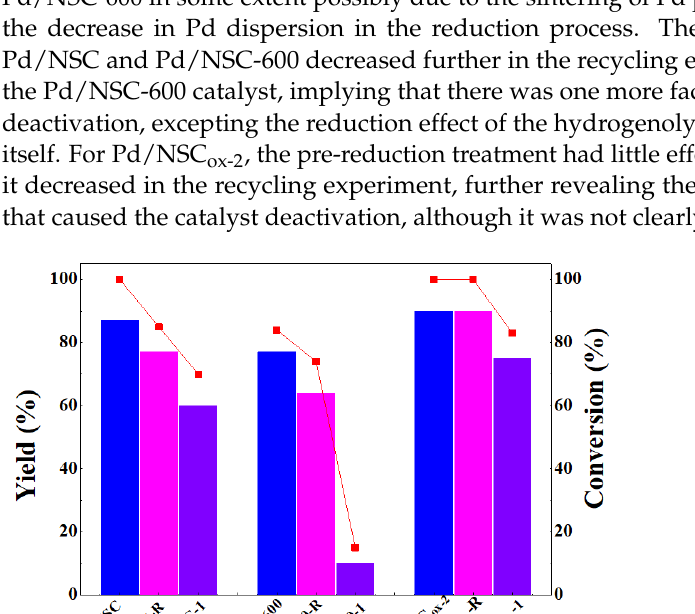
Figure 3. SEM images of NSC ( a ), NSC-600 ( b ), and NSC ox-2 ( c ). The N 2 adsorption–desorption isotherms of the three carbon supports are shown in Figure 4. The specific surface area, and pore volume of these supports are listed in Table 1. The isotherms of NSC, NSC-600, and NSC ox-2 samples showed a combination of type I and type IV curves with a type H3 hysteresis loop revealing the existence of the in- terparticle mesoporosity with the volume 0.9, 0.68, and 0.81 cm 3 /g, respectively. In addi- tion, its pore size distribution (PSD) curve (Figure S1) showed several peaks in the range of 0.5 to 100 nm, further confirming the existence of mesoporous and macroporous structures from the accumulation of carbon nanosheets. The hysteresis loop shapes and the pore size distributions (Figure S1) of NSC-600 and NSC ox-2 were similar to that of NSC, implying the similar textural properties of the carbon supports, so the effects of the textural properties of support on the performance of the corresponding catalysts could be diminish greatly. The surface area of NSC-600 was also similar to that of NSC (Table 1), while the data of NSC ox-2 (510 m 2 /g) decreased in certain extent possible due to the destruction of a few flowerlike microspheres during the oxidation. The surface area or- der of the three carbon samples, NSC-600 ≈ NSC > NSC ox-2 , was different from the activ- ity order of the corresponding catalysts, indicating that surface area of the carbon sup- port was not the main reason affecting the Pd dispersion and the activity of the Pd-based catalyst on carbon.